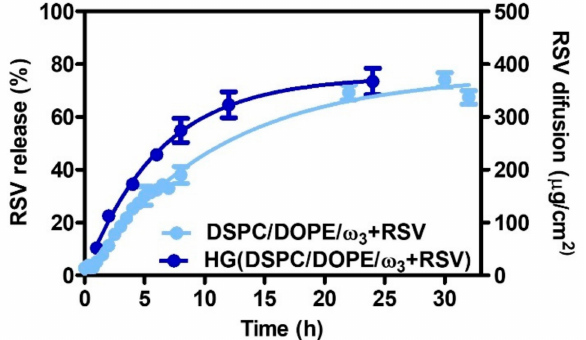
Figure 5. Release and diffusion profile of RSV from DSPC/DOPE/ ω 3 (6:3:1) in free form and included in the hydrogel (HG). The data represent the means ±